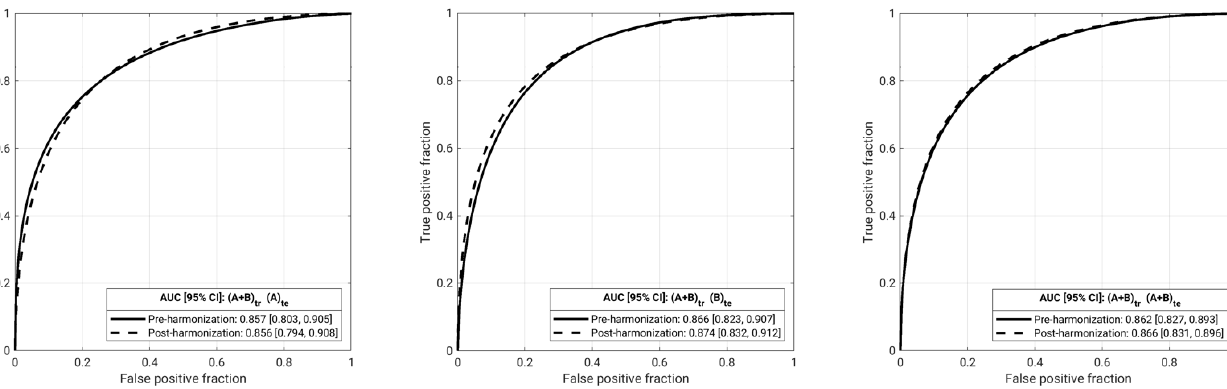
Figure 8. Classification performance results after batch feature harmonization and feature selection harmonization: Receiver operating characteristic (ROC) curves for the training and testing using a training set comprised of lesions from both databases. Solid lines show the ROC curve when using pre-harmonization features, while dashed lines show the ROC curve when using post-harmonization features. AUC values are given in Table 3 (A: Database A; B: Database B).